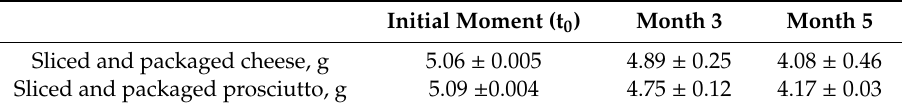
Figure 1. Images of the film. ( a ) Real image; ( b – d )—images captured using the confocal microscope. Table 2. Changes in the mass of packaged products during the testing